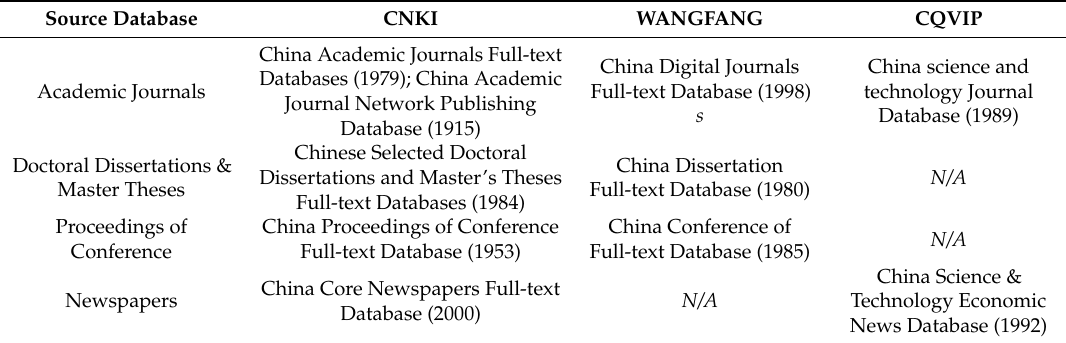
Table 1. Comparison of the three major Chinese